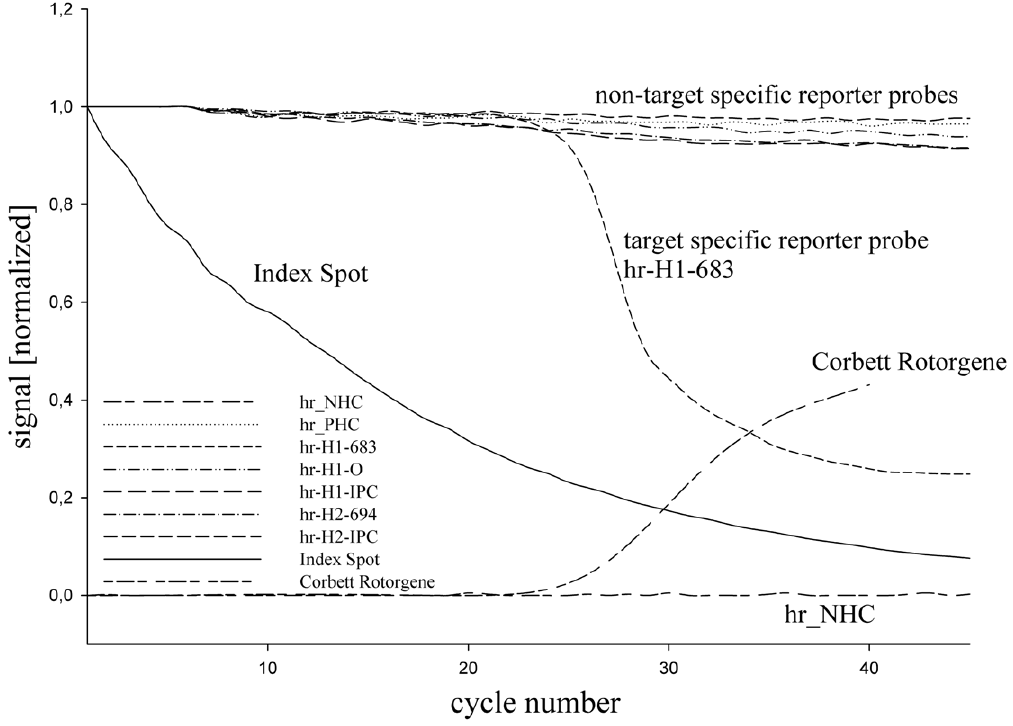
Figure 3. Hybridization signal dynamic on the micro array during a monoplex amplification reaction. The calculated signal intensities for the hybridization pattern of each acquired image were plotted against the cycle number. Images have been acquired after each cycle at the end of the annealing phase. Signal intensity decrease of about 70% can be observed at the HIV-1 target specific reporter probe hr_H1_683. The signal follows a typical sigmoidal dynamic with clearly recognizable phases of a PCR reaction. In contrast, for non- target specific reporter probes e.g. hr_H1_IPC, the decrease of signal intensity is linear and just about 5% from the initial value. Compared to the TaqMan data obtained by a real time PCR using the Corbet Rotorgene instrument, signals in the CMA experiment are discernable from background noise at about the same cycle number as in the reference experiment. Significant differences in bleaching behaviour are observed between fluorophores attached covalently to the surface and those attached to reporter probes.